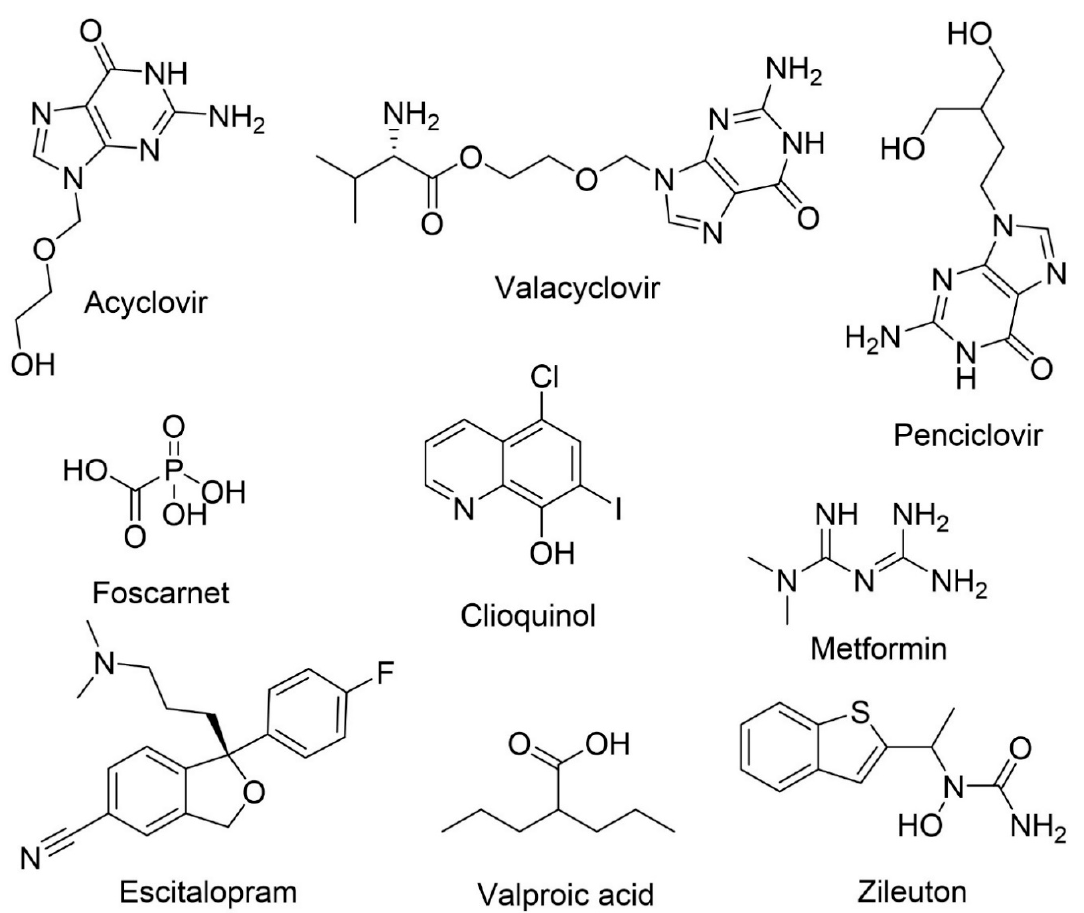
Figure 12. Chemical structures of potential agents for AD treatment.